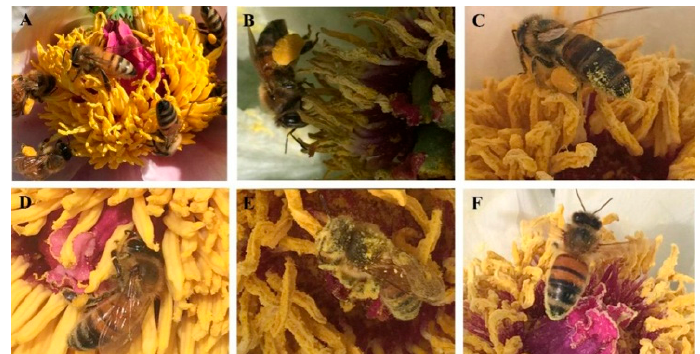
Figure 2. Foraging characteristics of A. mellifera on the oil tree peony ‘Feng Dan’. ( A ) Multiple bees collecting pollen on the same flower; ( B ) a bee collecting pollen from the outer ring of the androecium; ( C ) a bee crawling from the inner ring of the androecium toward the outer ring; ( D ) a bee collecting pollen from the inner ring of the androecium; ( E ) nearly the whole body of a bee contacts the stigma; ( F ) a bee grooming pollen above the stigma.